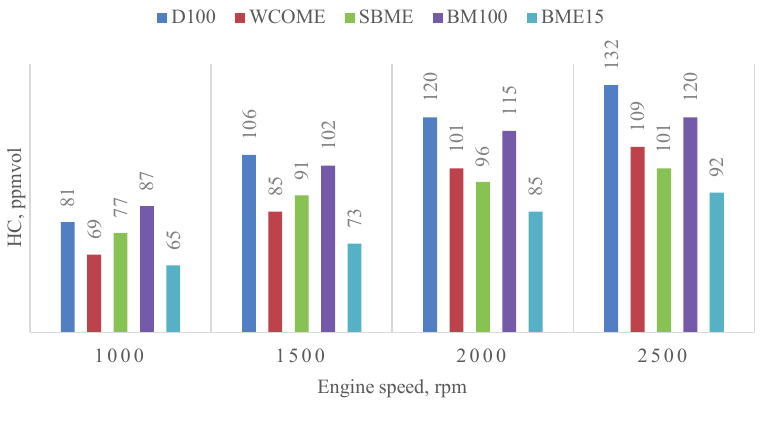
Fig. 8. Variation of hydrocarbon emissions with engine